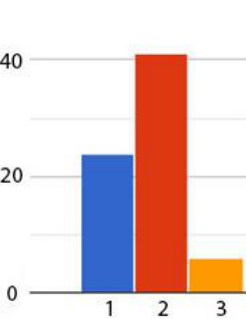
Table 4. Feedback survey questions (adapted after [41,54]).